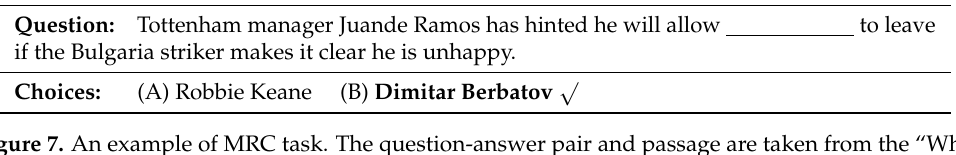
Figure 7. An example of MRC task. The question-answer pair and passage are taken from the “Who did What”